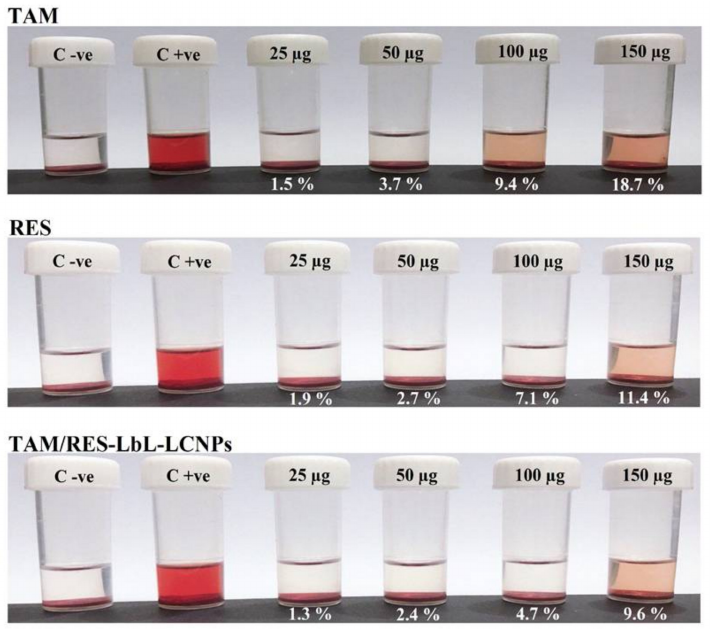
Figure 7. Hemolysis and blood smear stability of human RBCs. Percentage of hemolysis of TAM, RES, and other components involved in TAM/RES–LbL-LCNPs at different concentrations (25, 50,